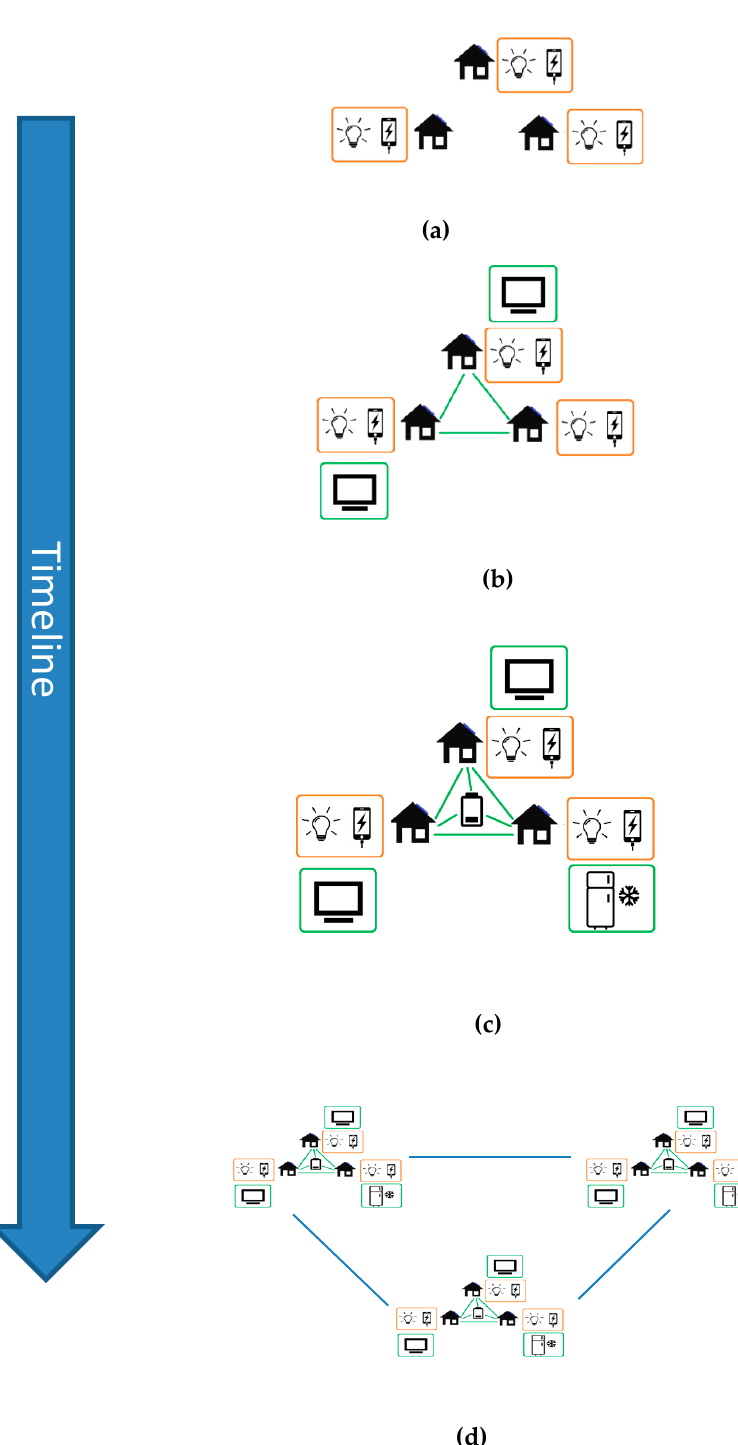
Figure 3. ( a ): Tier 1 access to electricity provided by standalone SHSs. ( b ): Tier 2 access to electricity provided by interconnecting SHSs. ( c ): Tier 3 access to electricity provided by adding centralized storage within a microgrid of interconnected SHSs. ( d ): Improved access to currently available appliances by interconnecting microgrids.